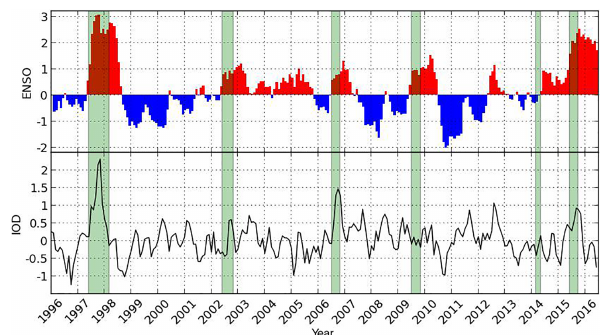
Figure 9. ENSO and IOD with periods of strongest fire activity highlighted in green (more than 5000AFmonth − 1 ; NOAA, 2016; OOPC,